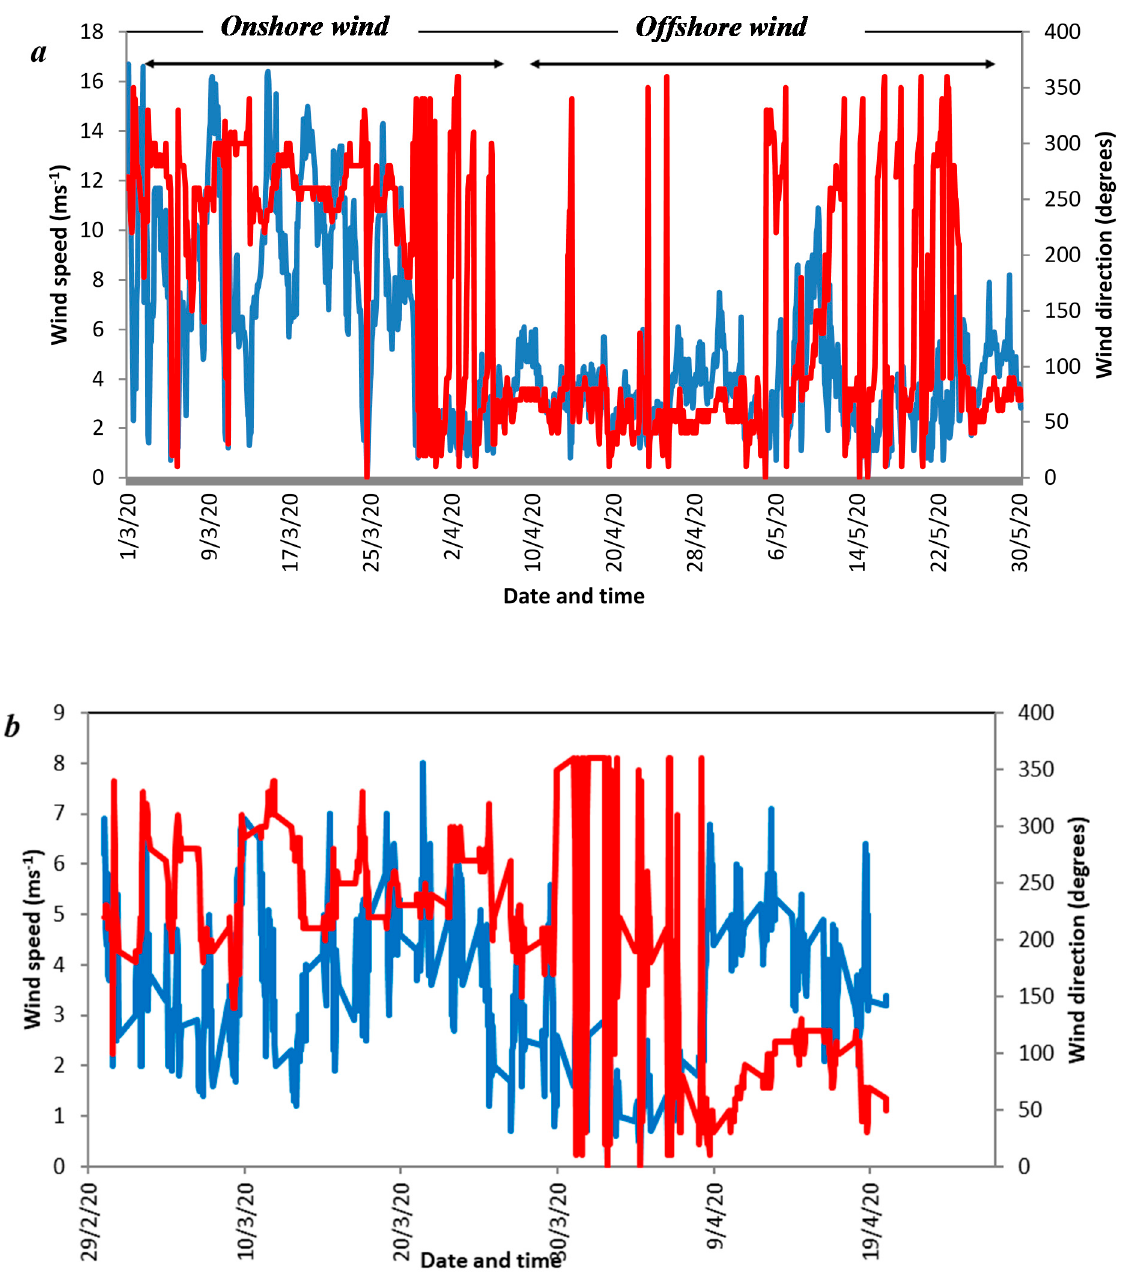
Figure 4. Time series of both the wind speed (the blue line) and direction (the red line) over March, and April 2020 in ( a ) the SEM-REV station located in Le Croisic near Nantes and ( b ) at the station of the Montsouris park in Paris. Above the figure 4a is reported the onshore and offshore wind episodes that occur in the coastal site.